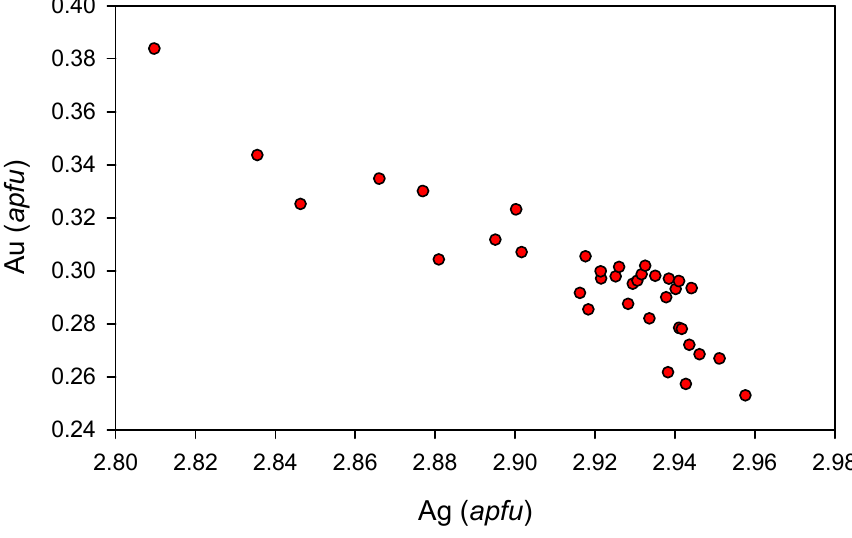
Figure 16. Chemical composition of dyscrasite in an Ag versus Au ( apfu ) plot. An unnamed (Au,Ag)Sb oxide mineral phase with a (Au+Ag)/(Sb+Bi+As+Fe+Hg+Zn) ratio in the range of 0.68–1.50 (mean 1.12), the low microprobe totals of 82.54–95.67 wt. % (Table S20), and a negative Au-Ag correlation (Figure 17) can correspond to the not-approved mineral „ auroantimonate “ [52,53] or AuSbO 3 oxide [54]. It is also possible (Figure 18) that it can be close to the so-called mustard gold [55,56], but its usual microporous character is not observed in our samples; moreover, the presence of oxygen in this phase was confirmed by the EDS spectra.